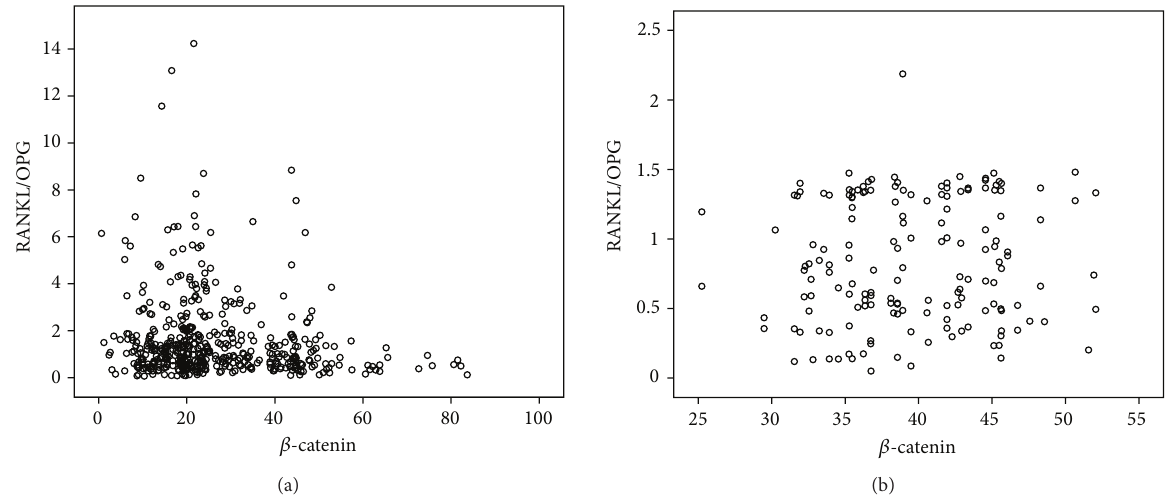
Figure 3: Univariate correlation (Spearman analysis) between 𝛽 -catenin and RANKL/OPG serum levels in PMOP patients ((a) 𝑟 = −0.128 , 𝑃 = 0.005 ) and controls ((b) 𝑟 = 0.032 , 𝑃 = 0.674 ).